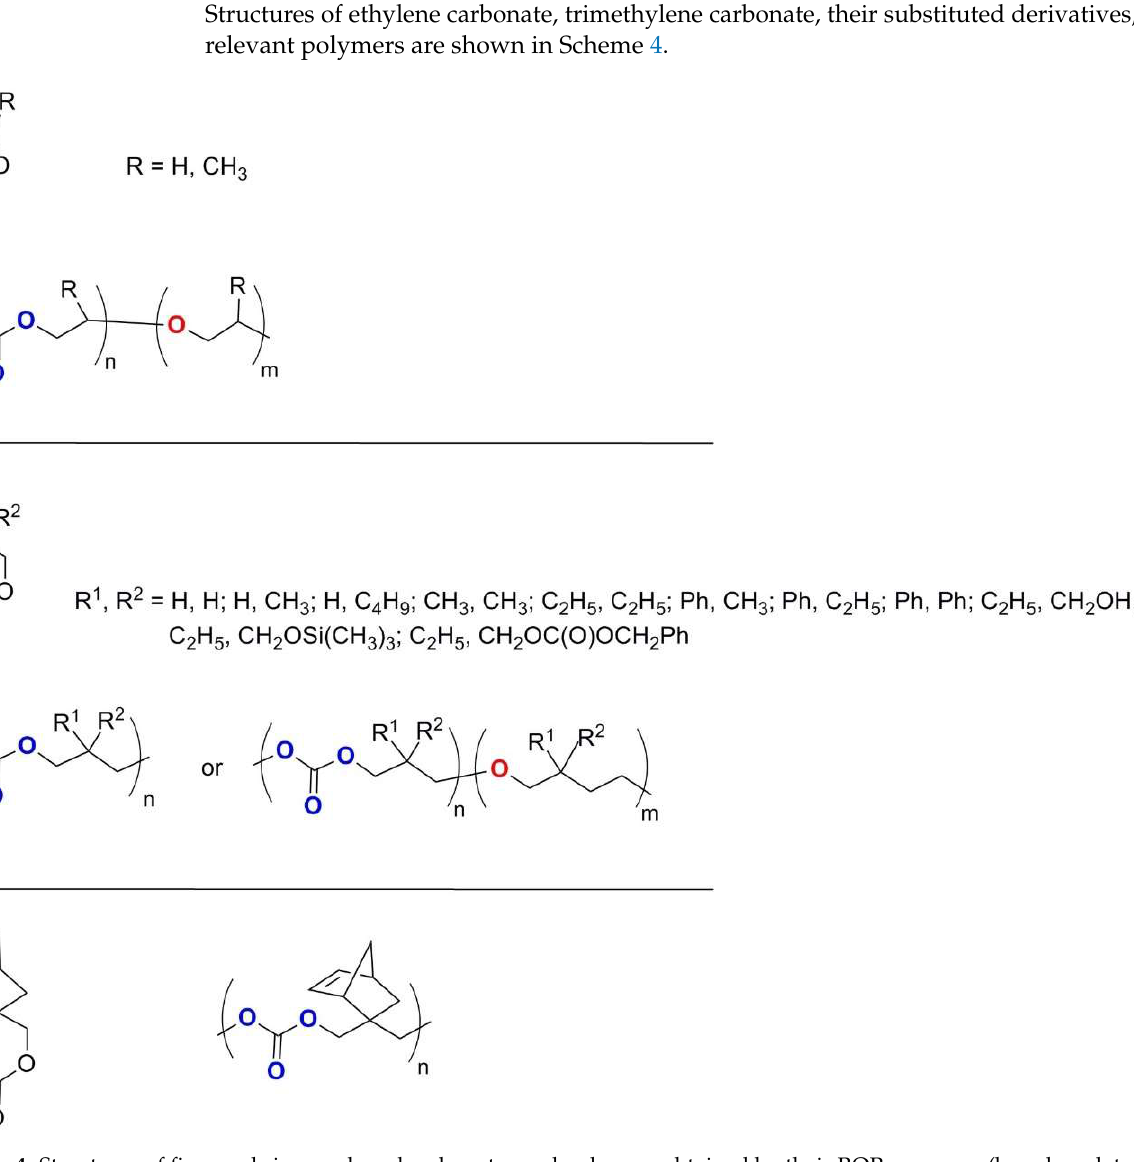
Scheme 4. Structures of five- and six-membered carbonates and polymers obtained by their ROP processes (based on data from References [51] and